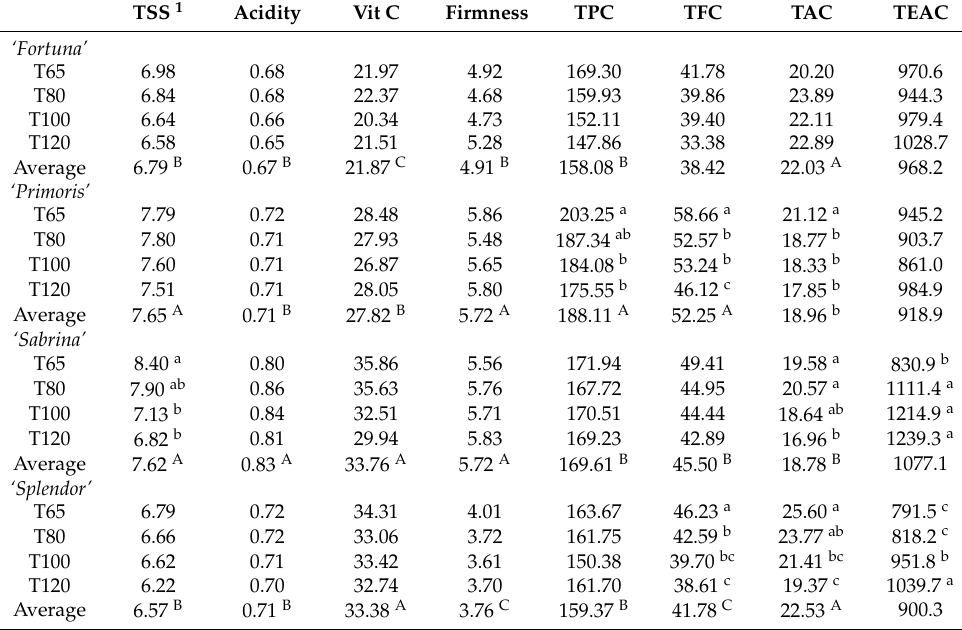
Figure 7. Water productivity (Kg m −3 ) of the study cultivars under the different water treatments supplied in the ( a ) 2016-2017 and ( b ) 2017–2018 cropping seasons. I. The effects of water treatments in the organoleptic fruit quality parameters were only significant in ‘Sabrina’, which showed higher TSS in the T65 and T80 water treatments (Table 3), and in ‘Rabida’, which displayed higher TSS and acidity values in the T80 (Table 4). Table 3. Mean values ( n = 9) of the organoleptic and functional fruit quality parameters in the four strawberry cultivars under the different water treatments supplied in the 2016–2017 cropping season. Each value is the mean of the three sampling dates (16 February 2017, 16 March 2017 and 21 April 2017). Within a cultivar, different superscript letters indicate significant differences ( p < 0.05) among water treatments. Capital letters indicate significant differences among cultivars ( p <